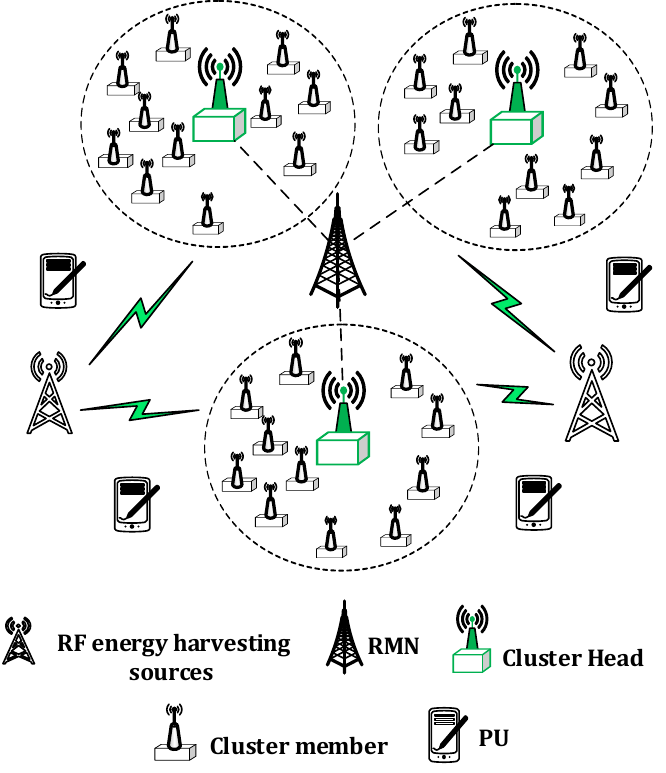
Figure 1. Proposed system